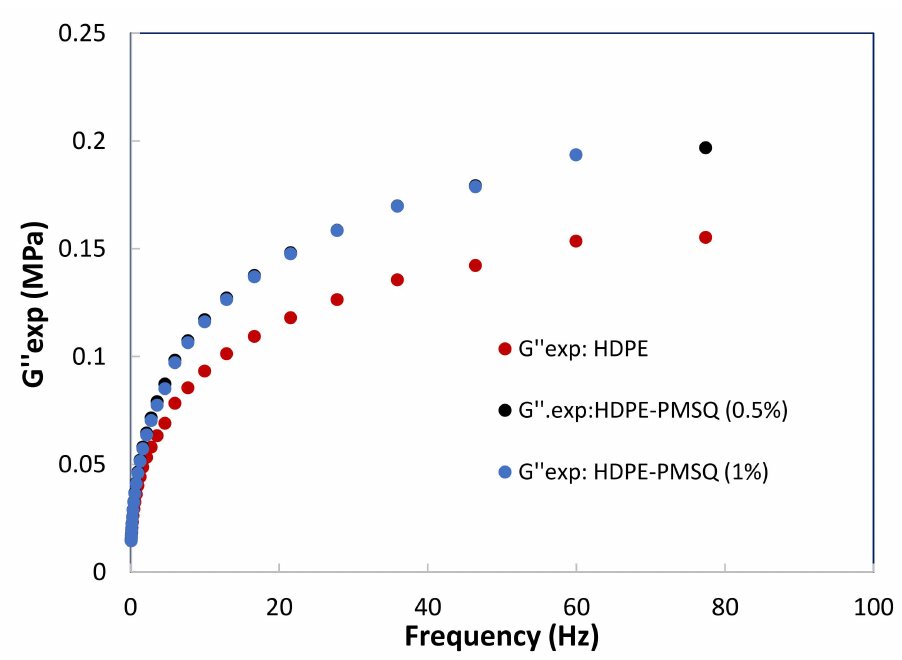
Figure 3. Experimental results of the loss moduli (G”) as a function of the PMSQ nanoparticles